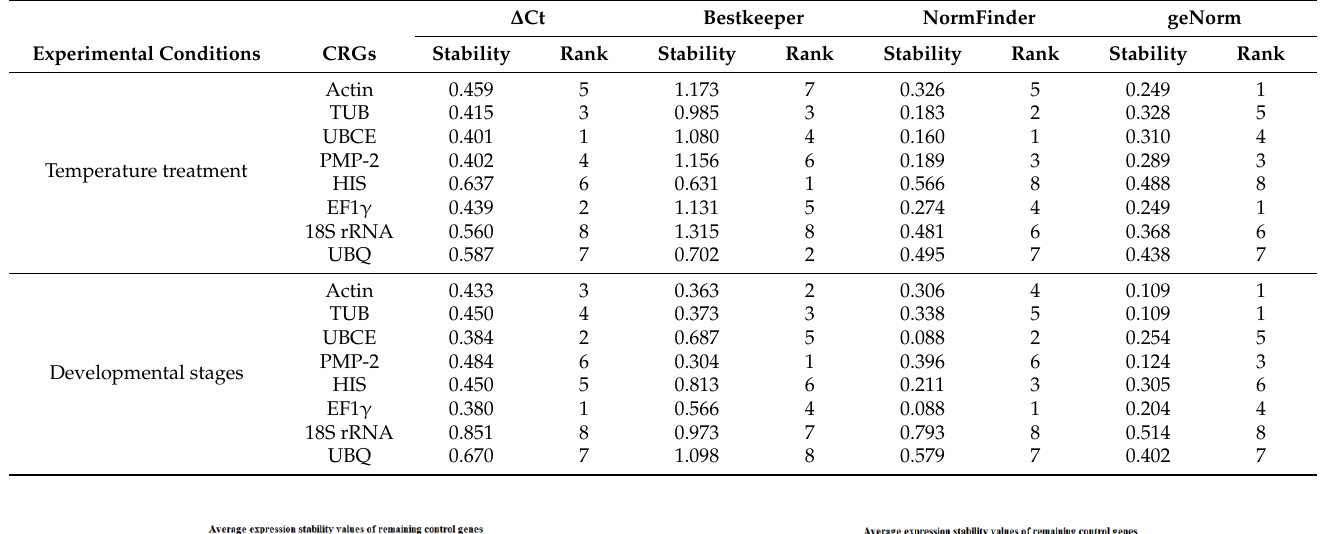
Table 2. Stability of eight candidate reference genes expression in B . xylophilus under different experimental conditions.